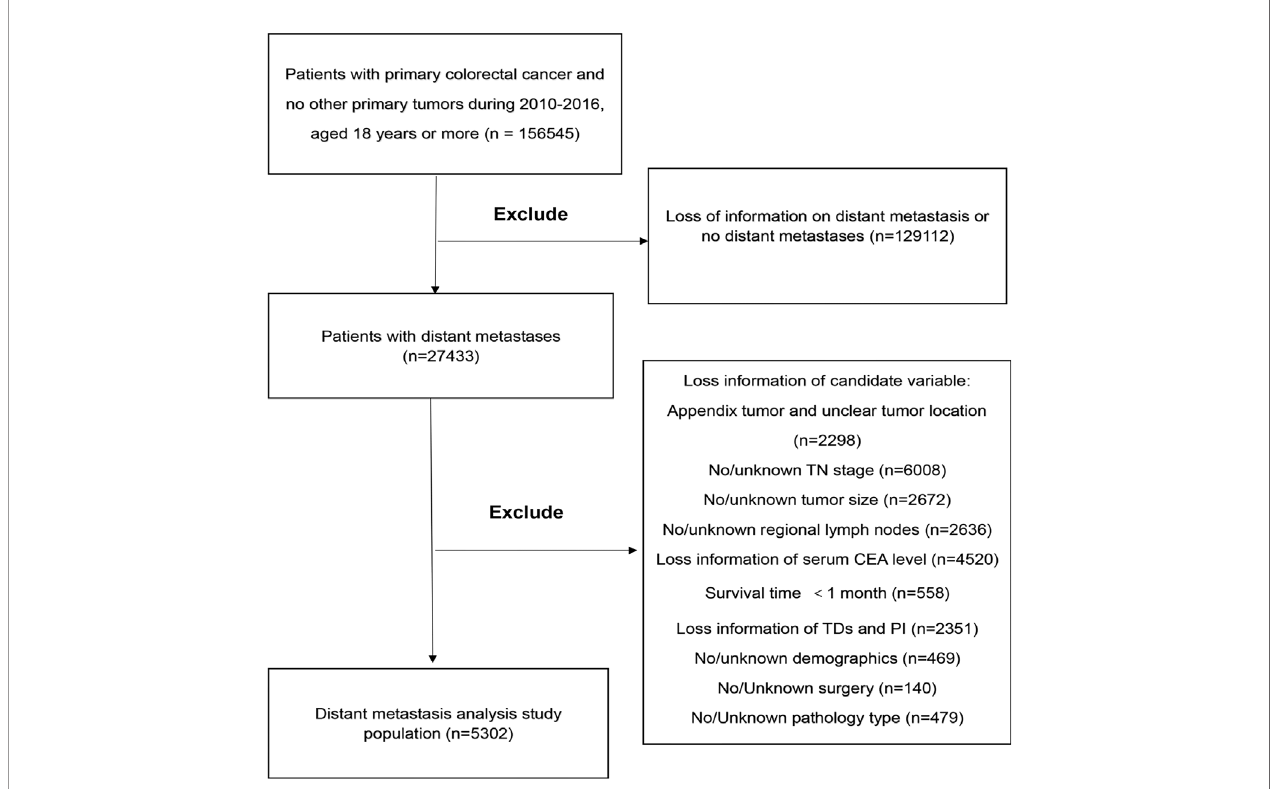
FIGURE 1 | The study fl ow diagram of the selection process. CEA, carcinoembryonic antigen; TDs, Tumor Deposits; PI, Perineural